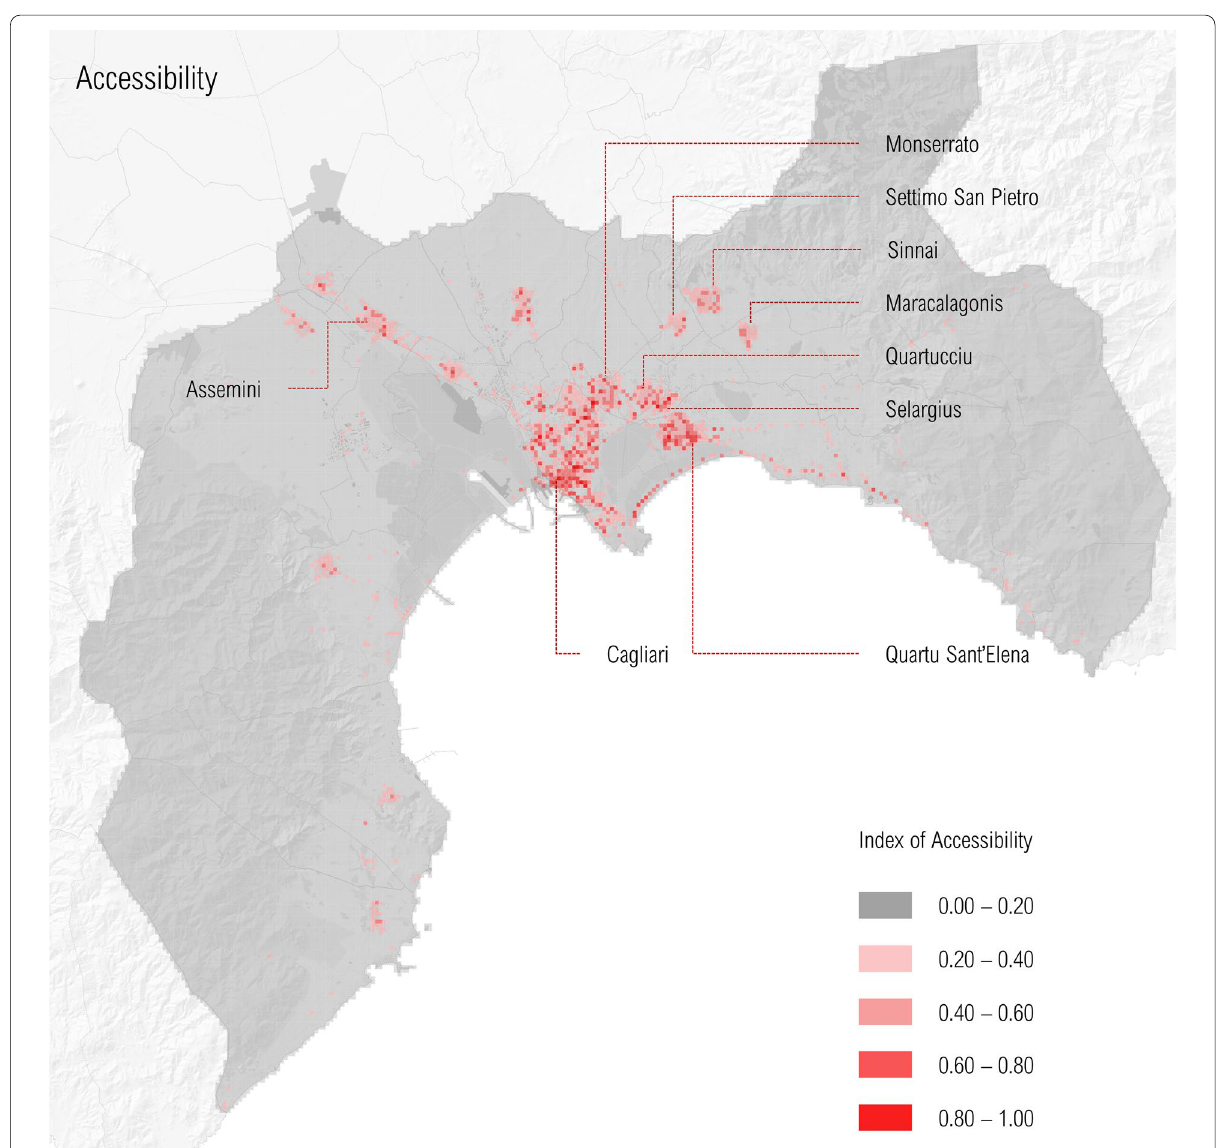
Fig. 10 Distribution of the values of the Index of Accessibility (I_ACC) across the Metropolitan City of